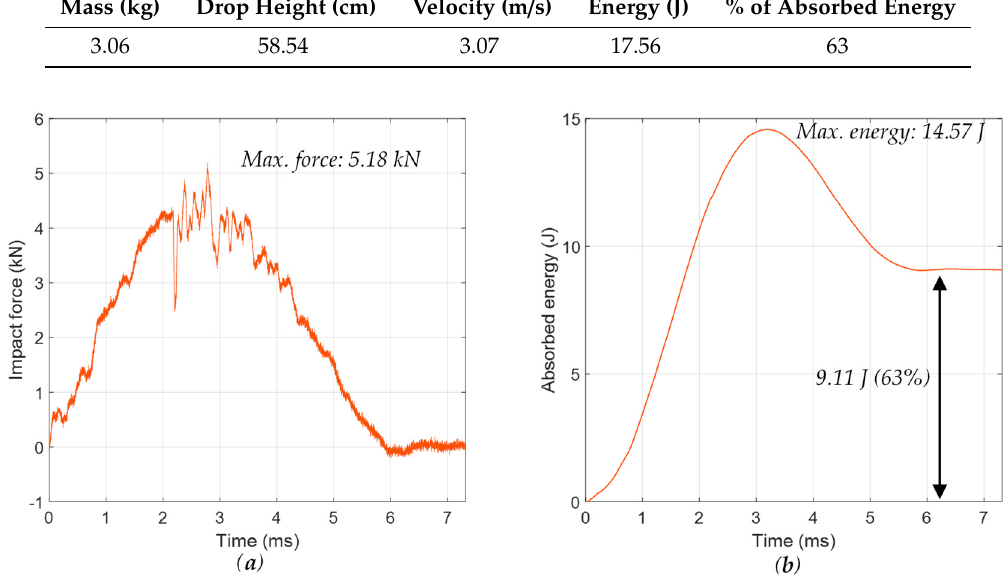
Table 3. Impact testing conducted on the 3-mm-thick quasi-isotropic composite coupon.